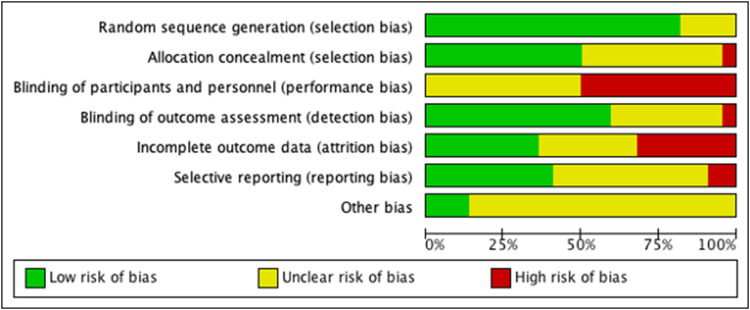
. Risk of bias in included studies.